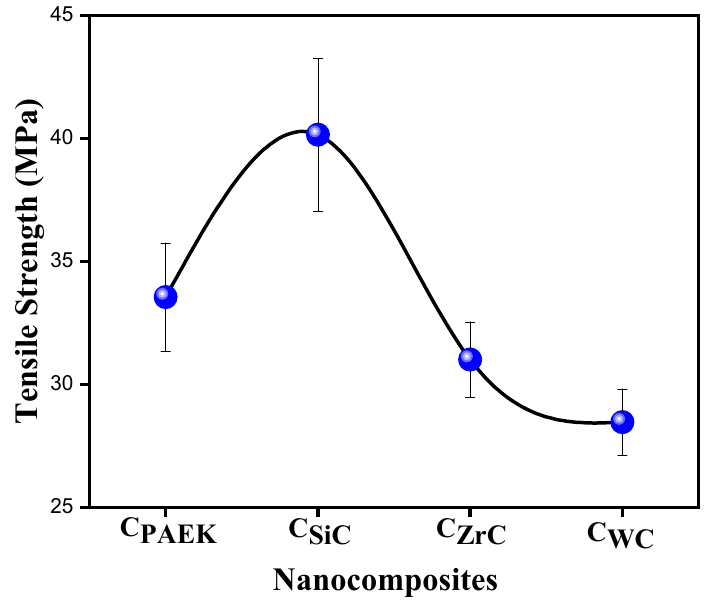
Figure 9. Tensile strength of developed NCs.